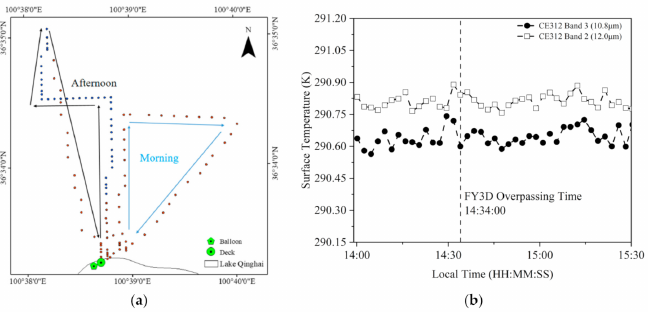
Figure 3. The surface temperature observed along the navigation route ( a ), and its variation during FY − 3D MERSI-II overpass on 18 August 2019 ( b